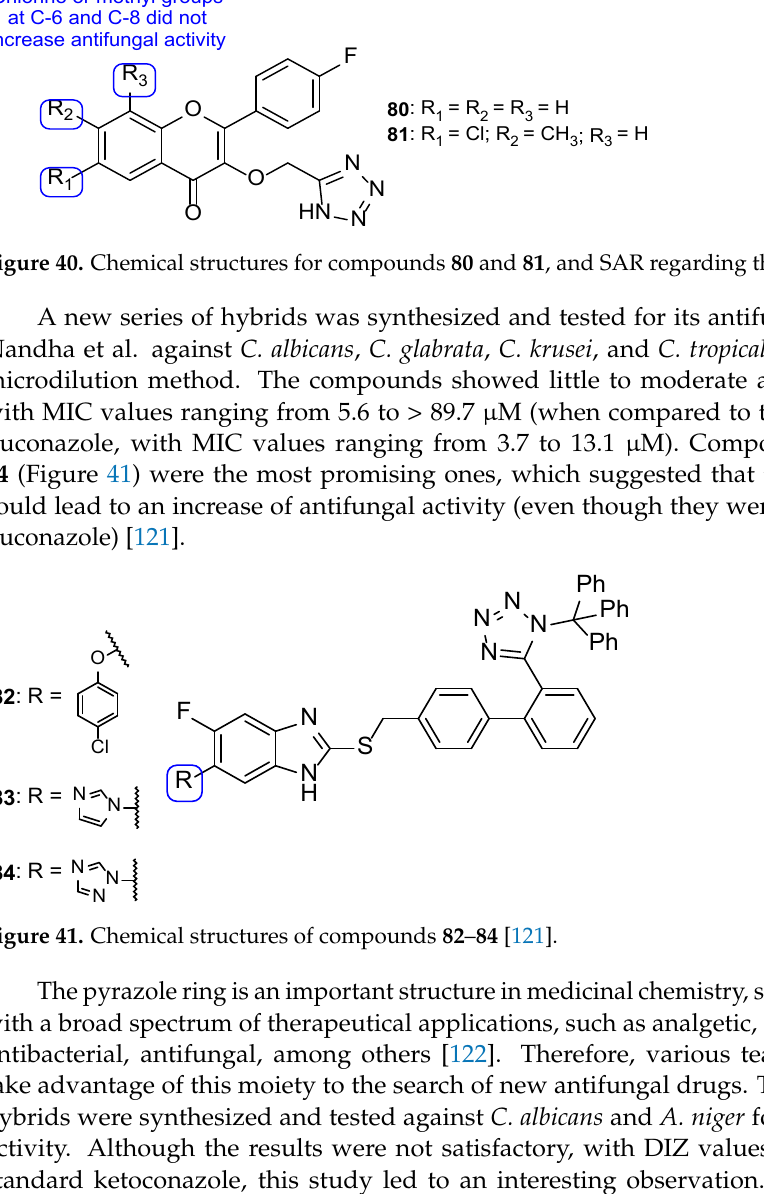
Figure 39. Chemical structures for compounds 76 – 79 , and SAR [119] .